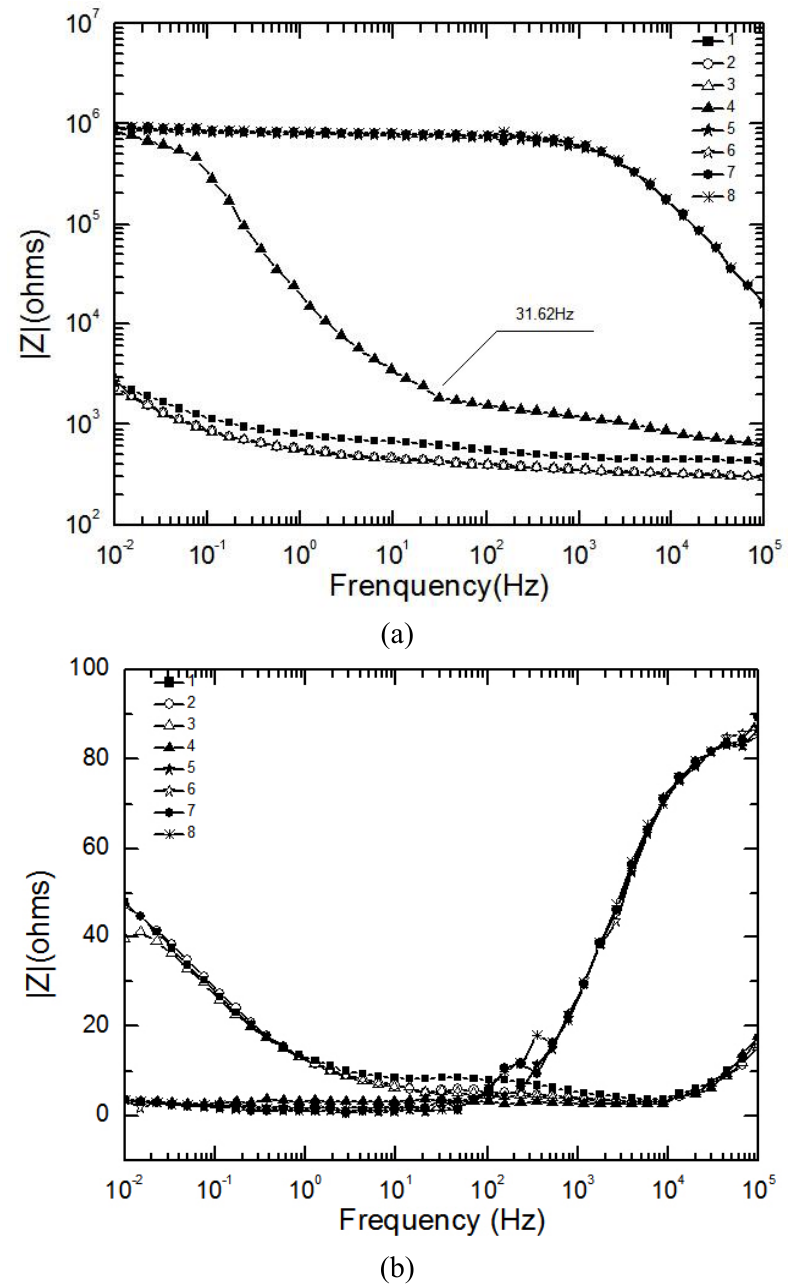
Figure 7. EIS results of 50 th cycle: (a) Bode diagram (|Z|); (b)Bode diagram (Phase of